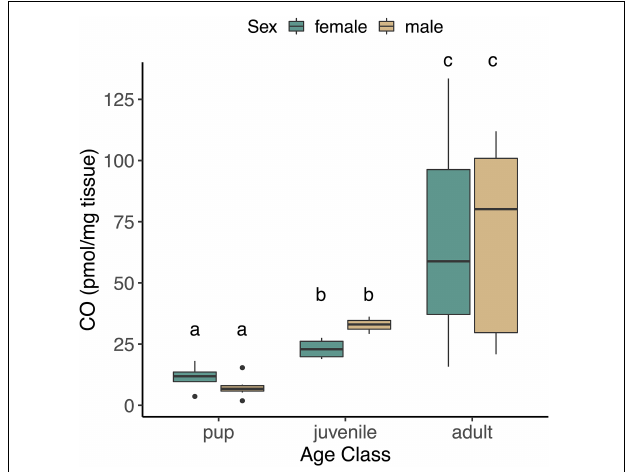
FIGURE 1 | CO levels measured in skeletal muscle of NES pups ( n = 13; 4 female, 9 male), juveniles ( n = 7; 4 female, 3 male), and adults ( n = 20; 10 female, 10 male). Different letters denote significant differences between groups (GLM using log-transformed CO, followed by post hoc EMM test, p <